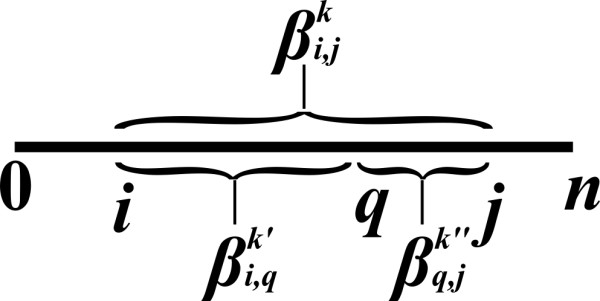
The examination of a split position q in the computation of an inside property βi,jk.